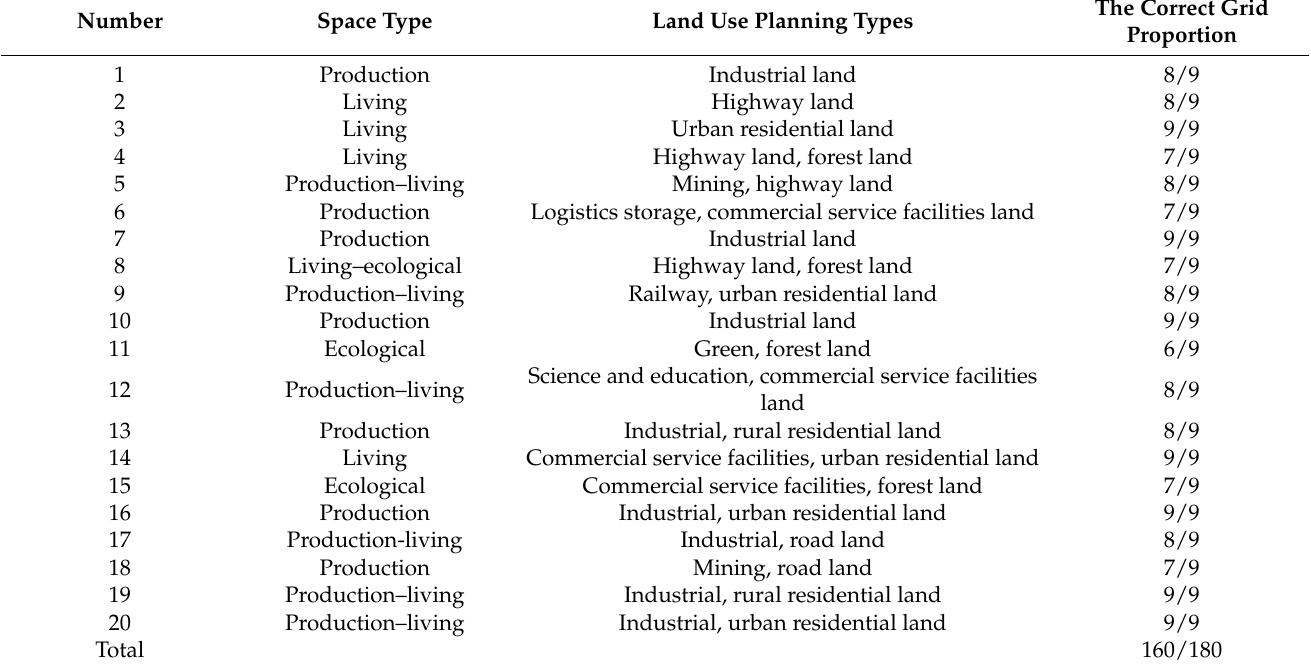
Table 5. The validation results of PLE